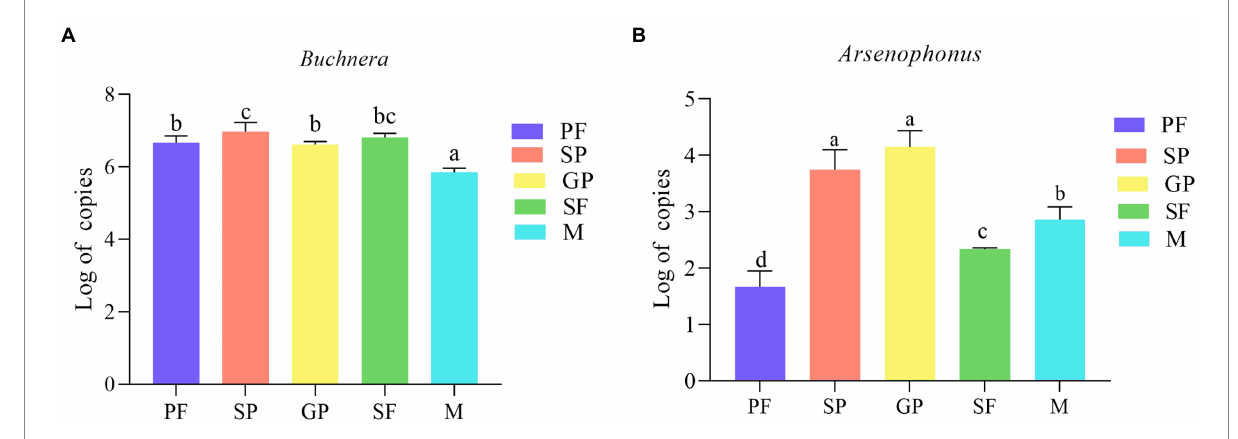
FIGURE 6 Copy number of Buchnera (A) and Arsenophonus (B) in five A . gossypii reproductive morphs. Copy number is represented by logarithmic 10 transformed value (Log 10). Significant differences were examined via one-way ANOVA. Columns (Mean ± SE) with the same letters are not significantly different (Duncan test; p > 0.05). PF, parthenogenetic females; SP, sexuparae; GP, gynoparae; SF, sexual females; M,